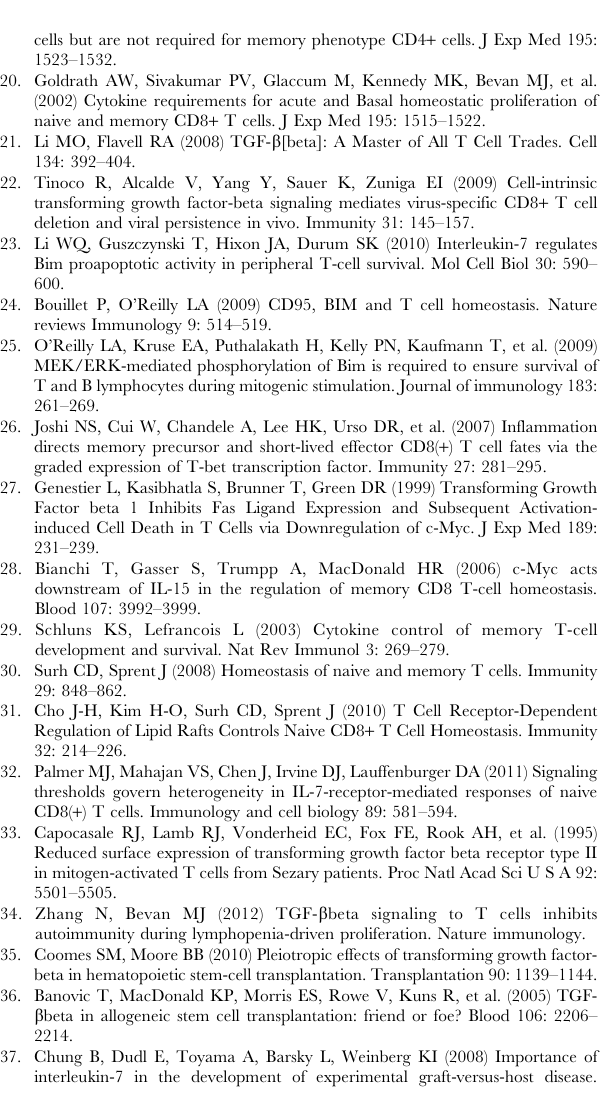
Figure S4 OT-I/DN RII CD8 T cells are maintained at an elevated frequency after host has refilled. OT-I Rag 2 / 2 and OT-I/DN RII Rag 2 / 2 CD8 T cells were transferred into sub-lethally irradiated hosts and analyzed 3 and 12 weeks after transfer. OT-I/DN RII and OT-I/DN RII Rag 2 / 2 CD8 T cells behave equivalently in response to lymphopenia (data not shown). The data are representative of 3 mice per group, from two independent experiments. Figure S5 Similar sensitivity of naive OT-I and OT-I/ DNRII CD8 T cells to high and low affinity TCR